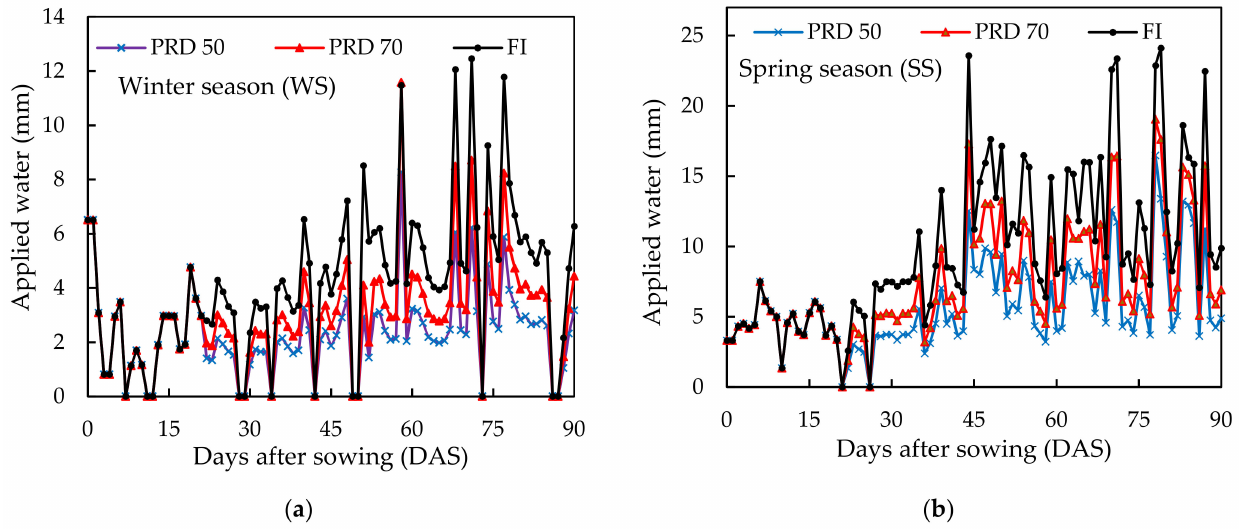
Figure 4. Seasonal water application to zucchini squash crops for the two growing seasons: ( a ) Winter season, and ( b ) spring